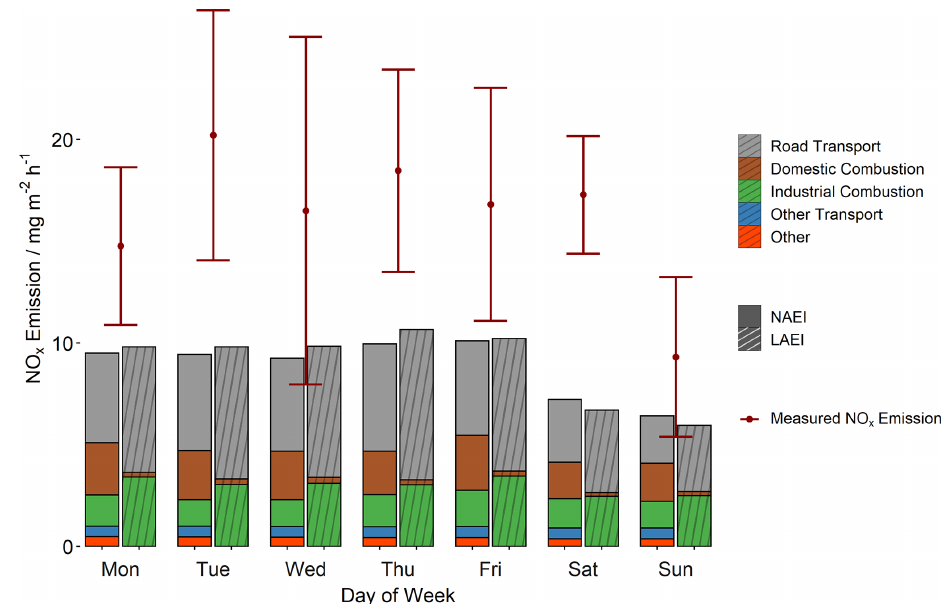
Figure 10. Daily averaged measured NO x emissions by day of week shown as red points and stacked bars of simulated emissions coloured by source sector for the NAEI (solid colour) and LAEI